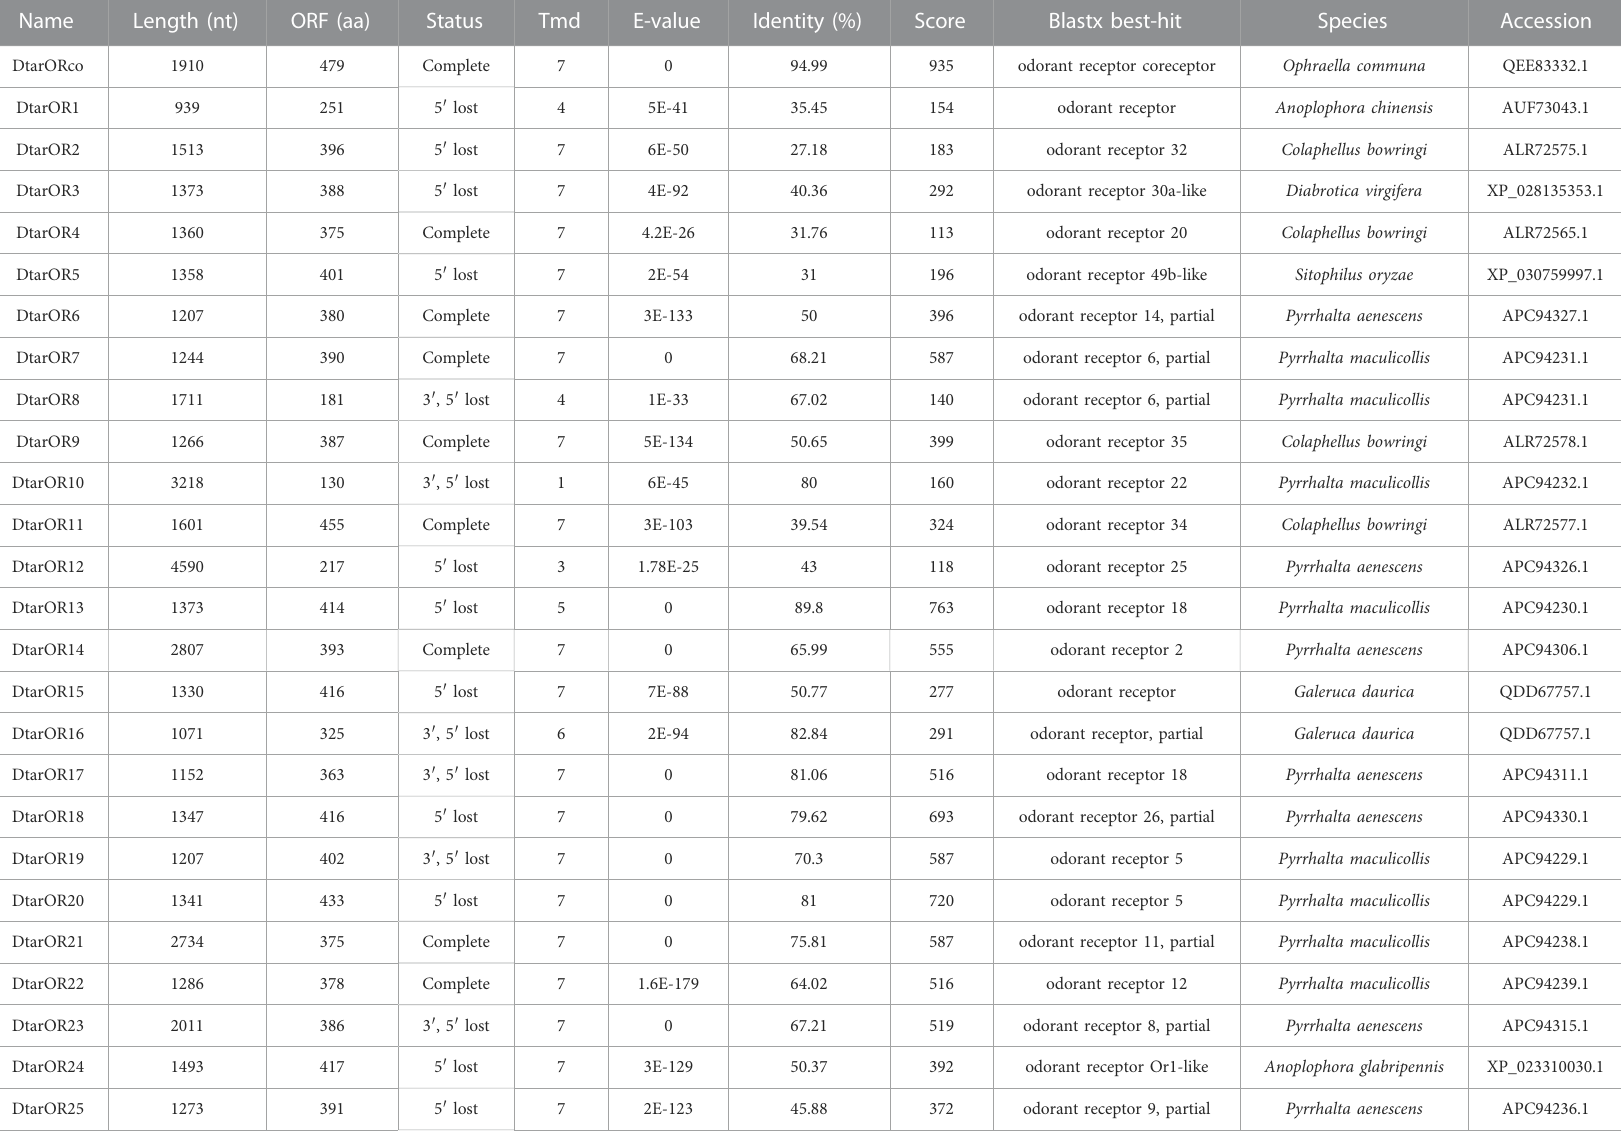
TABLE 1 List of odorant receptor genes in D. tarsalis antennal